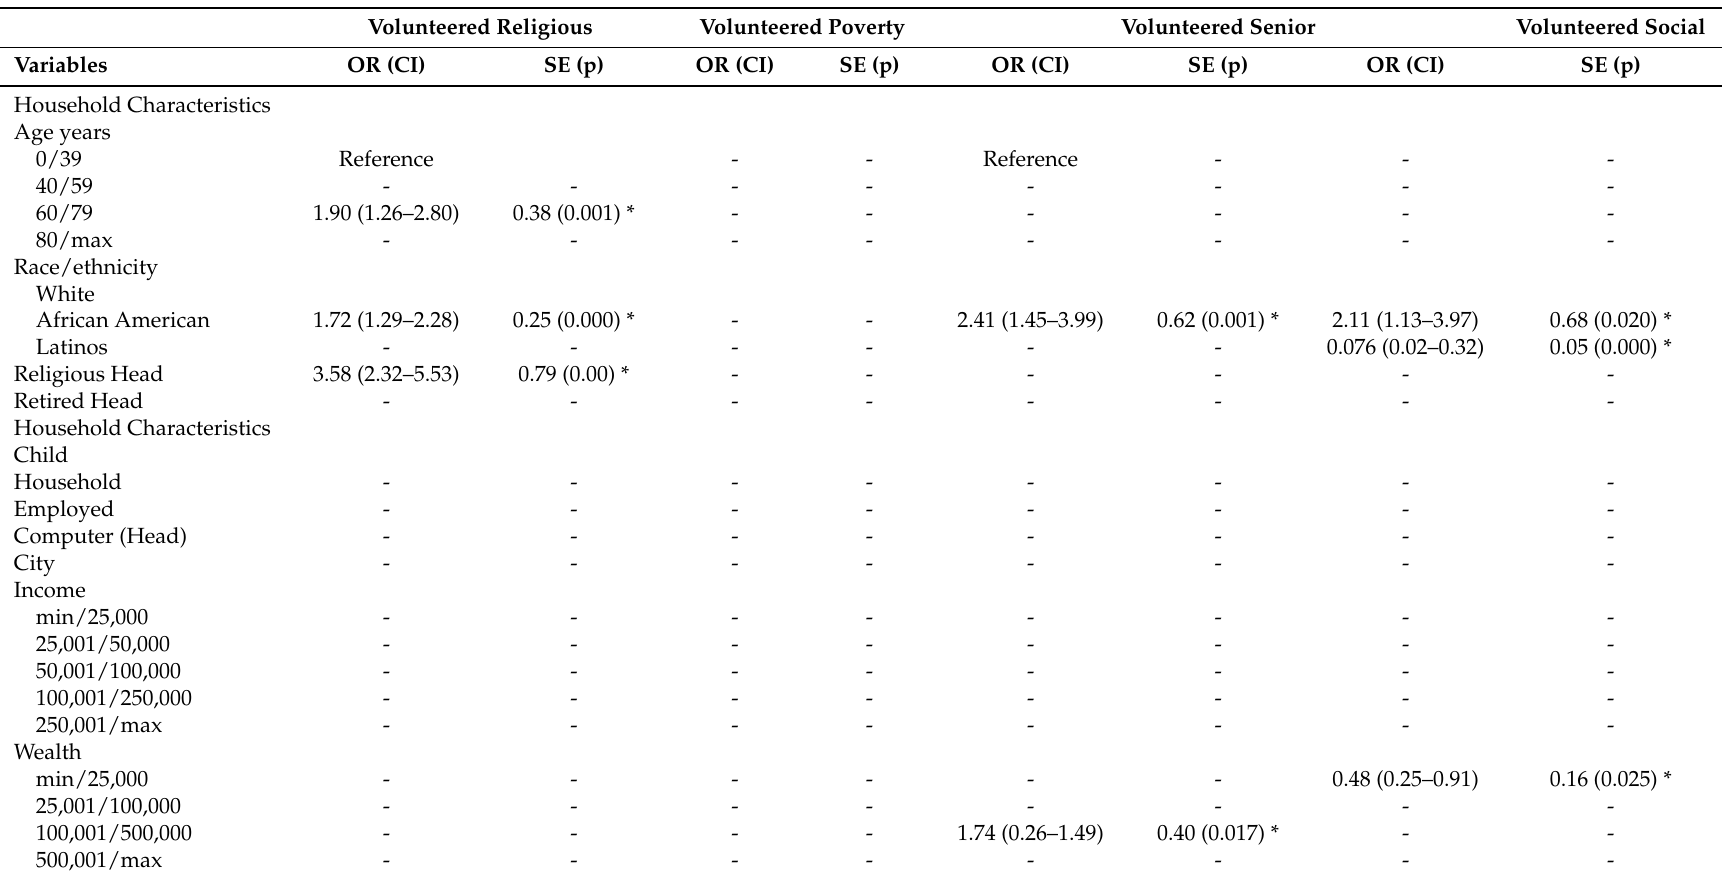
Table 7. A multivariate analysis predicting wife volunteering in organizations